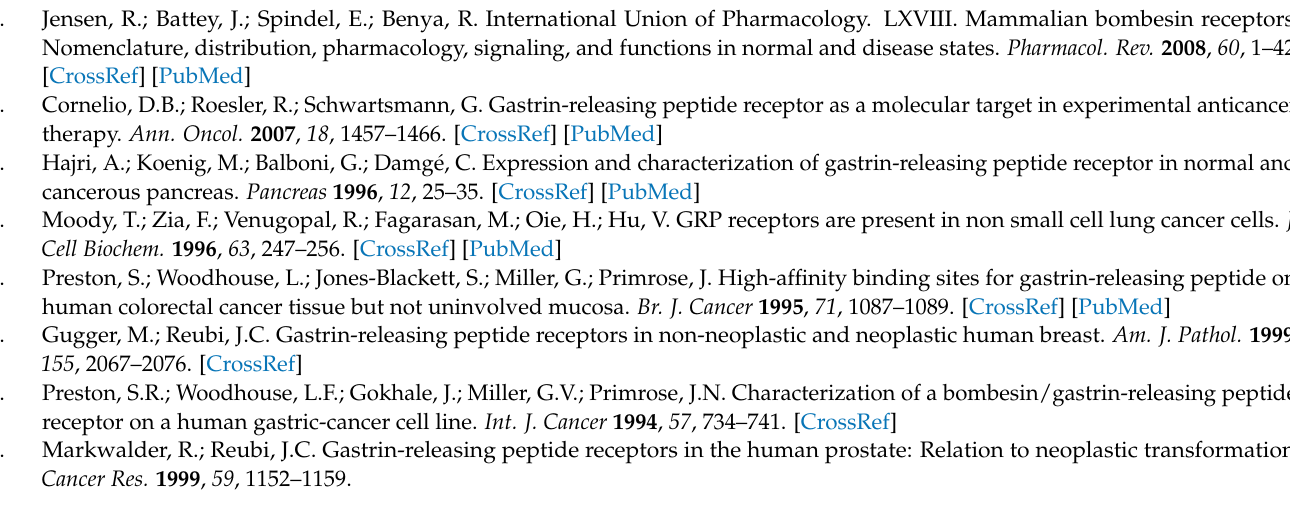
Table S3: HPLC conditions for the purification and quality control of 68 Ga-labeled TacsBOMB2, TacsBOMB3, TacsBOMB5, and TacsBOMB6; Table S4: Biodistribution (mean ± SD, n = 4) and uptake ratios of 68 Ga-labeled GRPR-targeting tracers in PC-3 tumor-bearing mice; Figure S1: Representa- tive radio-HPLC chromatograms from analysis of intact fraction of [ 68 Ga]Ga-TacsBOMB2 in mouse plasma (a) and urine (b) samples collected at 15 min post-injection; Figure S2: Representative radio- HPLC chromatograms from analysis of intact fraction of [ 68 Ga]Ga-TacsBOMB5 in mouse plasma (a) and urine (b) samples collected at 15 min post-injection; Figure S3: Representative radio-HPLC chromatograms from analysis of intact fraction of [ 68 Ga]Ga-RM2 in mouse plasma (a) and urine (b) samples collected at 15 min post-injection; Figure S4: The proposed chemical structure of the observed by-product from cleavage of protected TacsBOMB2 off the Rink Amide MBHA resin; Figure S5: MS analysis of the observed by-product